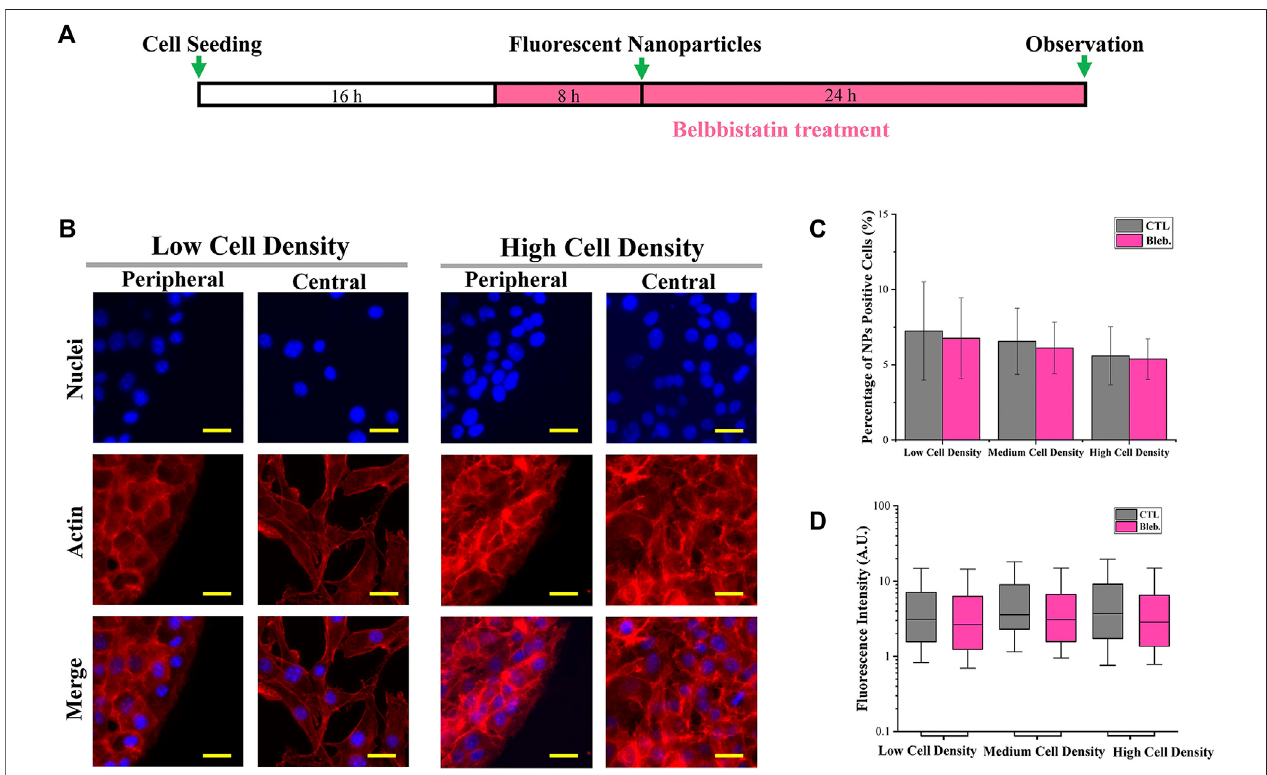
FIGURE 6 | In fl uence of the cytoskeleton structure on cellular uptake capacity. (A) Scheme of blebbistatin treatment. (B) Structure of actin after blebbistatin treatment( d =1.2 mm).Scalebar:50 μ m. (C) PercentageofNP-positivecellsafterblebbistatintreatment( d =1.2 mm).Dataarepresentedasmeans±SDs( n > 30). (D) Fluorescence intensity of NP-positive cells after blebbistatin treatment (1.2 mm). Data are presented as means ± SDs ( n >